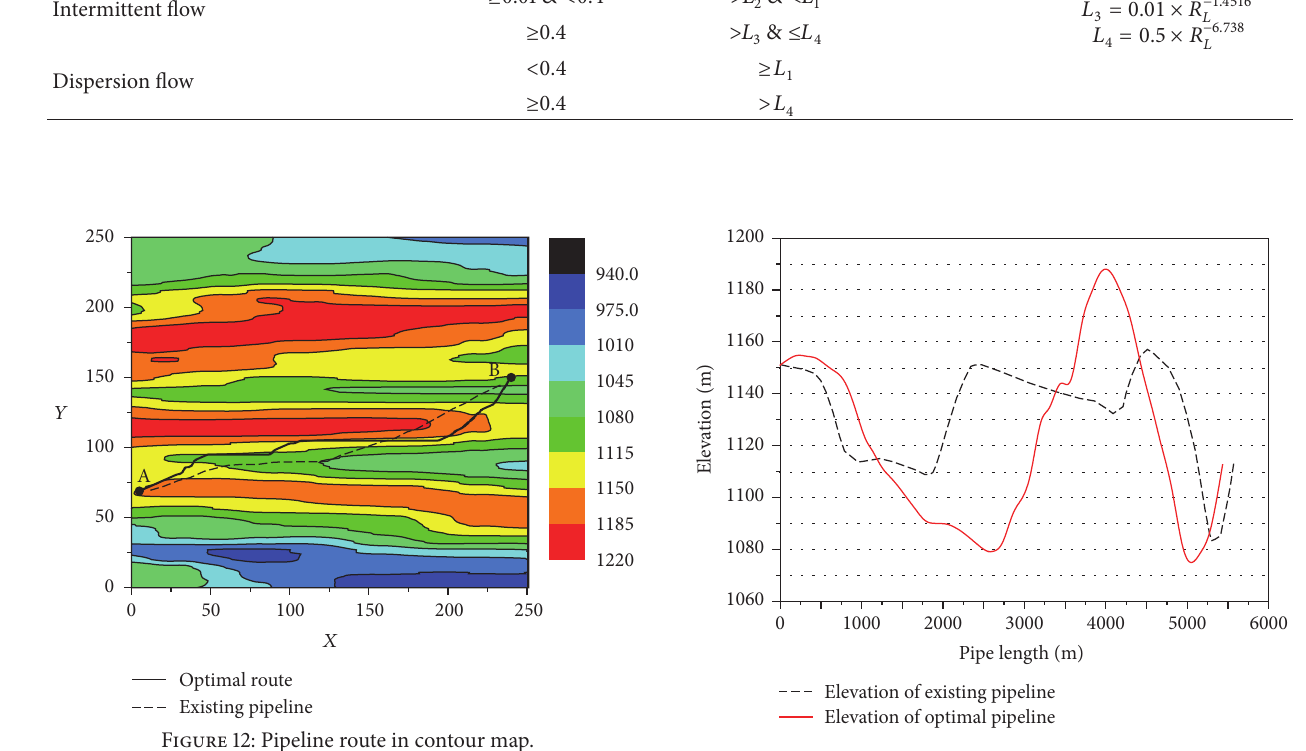
Figure 12: Pipeline route in contour map.